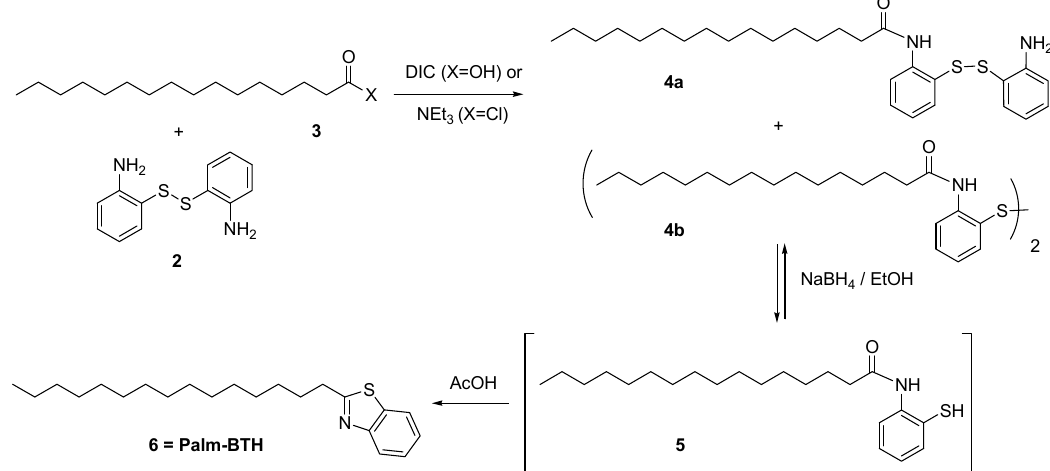
Scheme 2. Synthetic method for the formation of Palm-BTH; Compound 3 was used either as palmitic